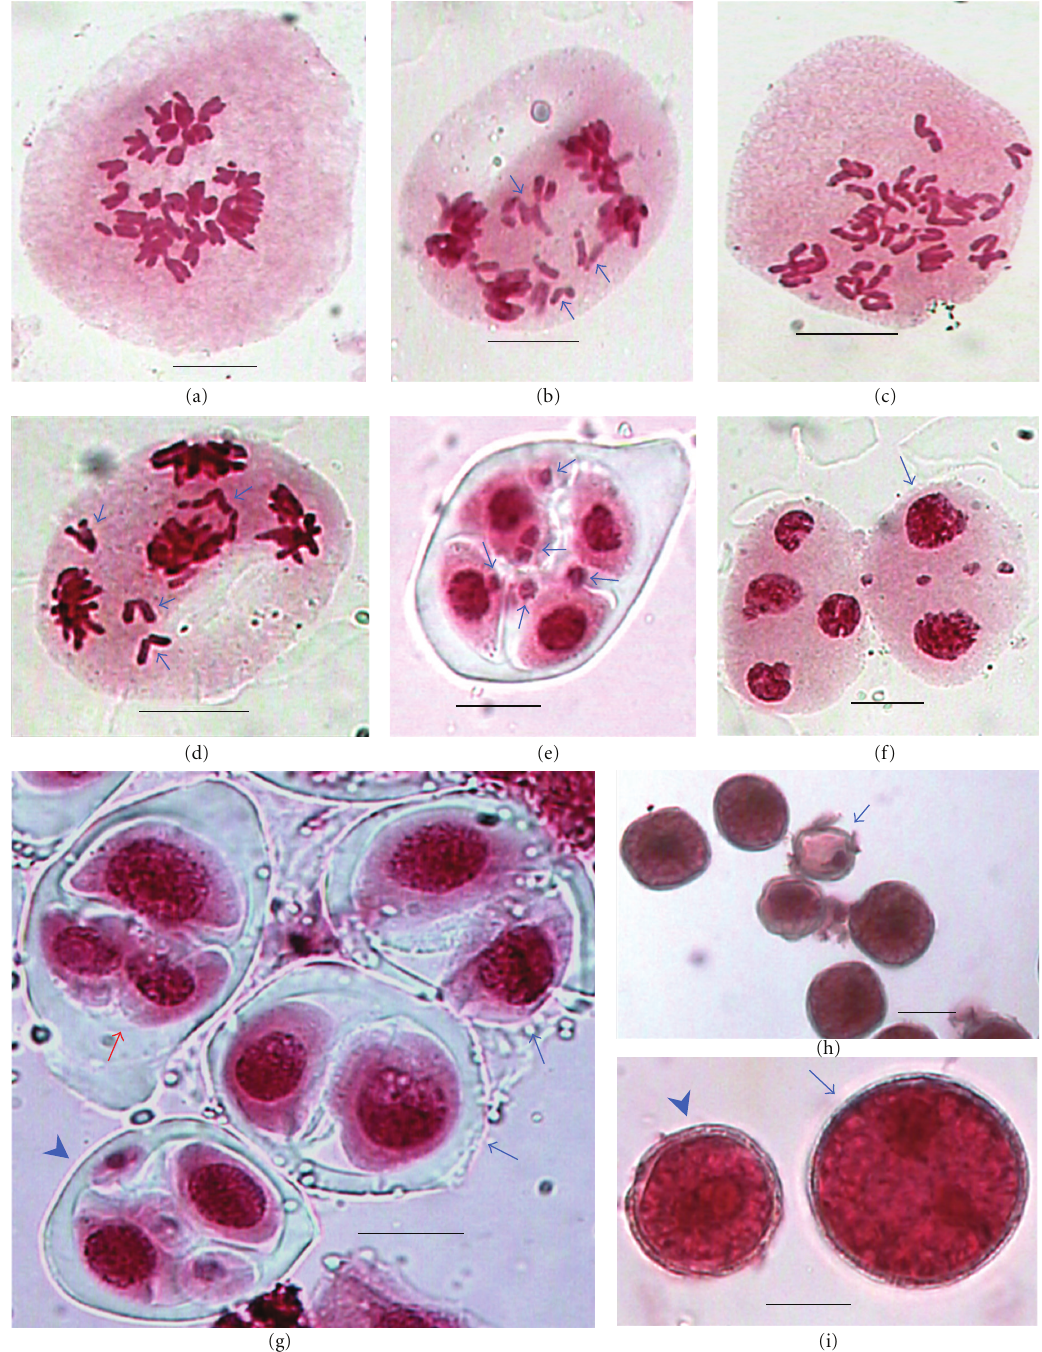
Figure 4: (a–i) Meiocytes with erratic male meiosis at second meiotic division in R. laetus. (a) Unequal distribution of chromosomes (10: 18) at M-II. (b) Scattered chromosomes at anaphase-II (arrowed). (c) Random and unoriented distribution of chromosomes at M-II. (d) A PMC showing lagging of chromosomes (arrowed). (e) Tetrad with micronuclei (arrowed). (f) Out of the two PMCs, one showing restitution (unreduced) nuclei (arrowed) and the other with four haploid nuclei at T-II. (g) Sporads in group; dyads with micronuclei (arrowhead), dyads without micronuclei (blue arrows), and triads (red arrow). (h) Apparently stained fertile and unstained or lightly stained, and shriveled sterile (arrowed) pollen grains. (i) Apparently stained fertile n (reduced, arrowhead) and 2 n (unreduced, arrowed) pollen grains. Scale bar = 10 µ m (a–d); 20 µ m